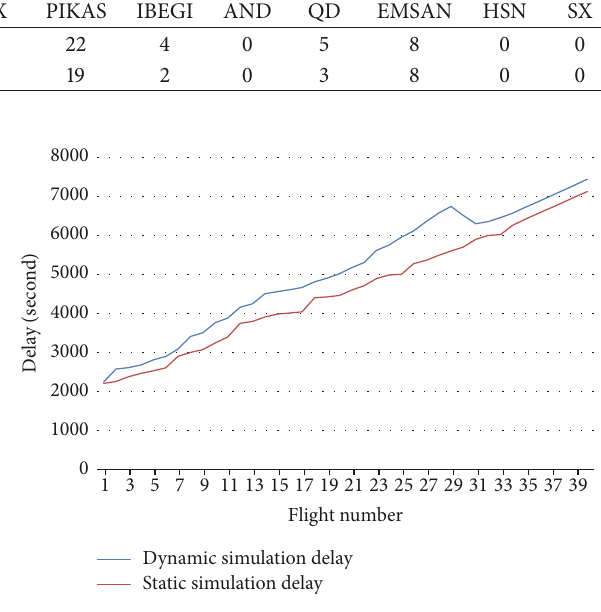
Figure 14: Comparative analysis of aircraft